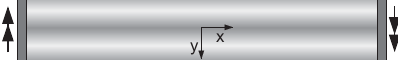
Figure 6: Load case 4 illustration